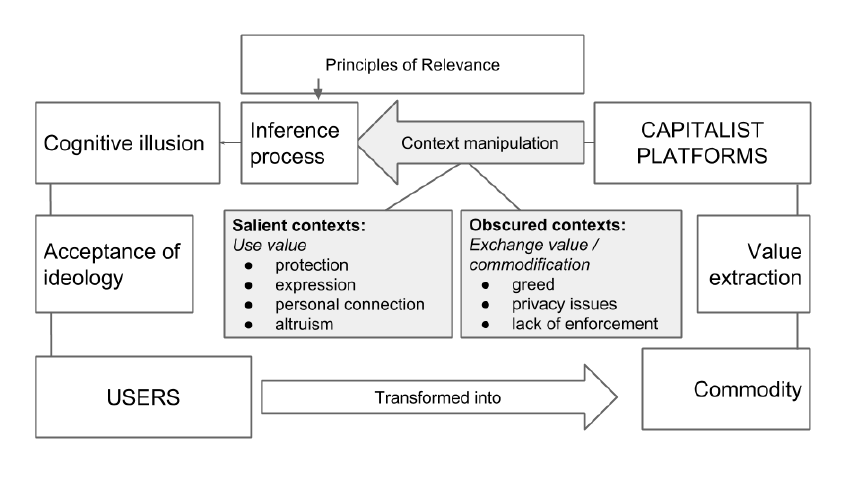
Figure 1. Cognitive-pragmatic model of ideology illustrating commodification of online